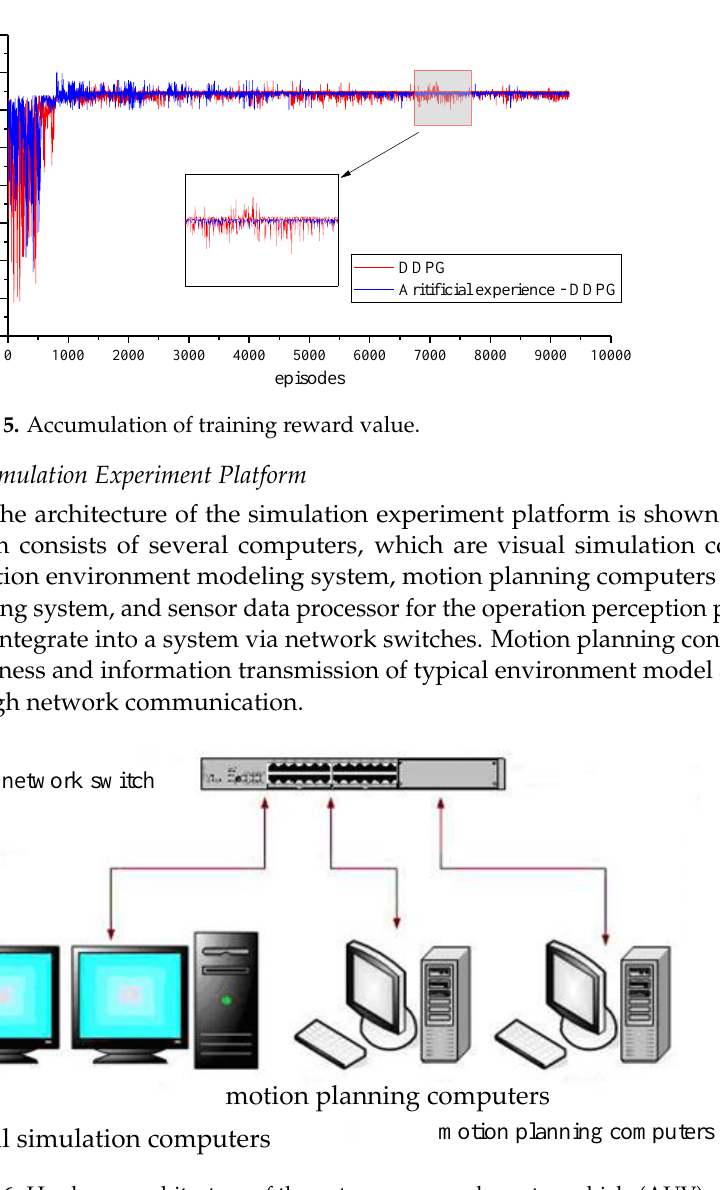
Figure 6. Hardware architecture of the autonomous underwater vehicle (AUV) simulation platform.